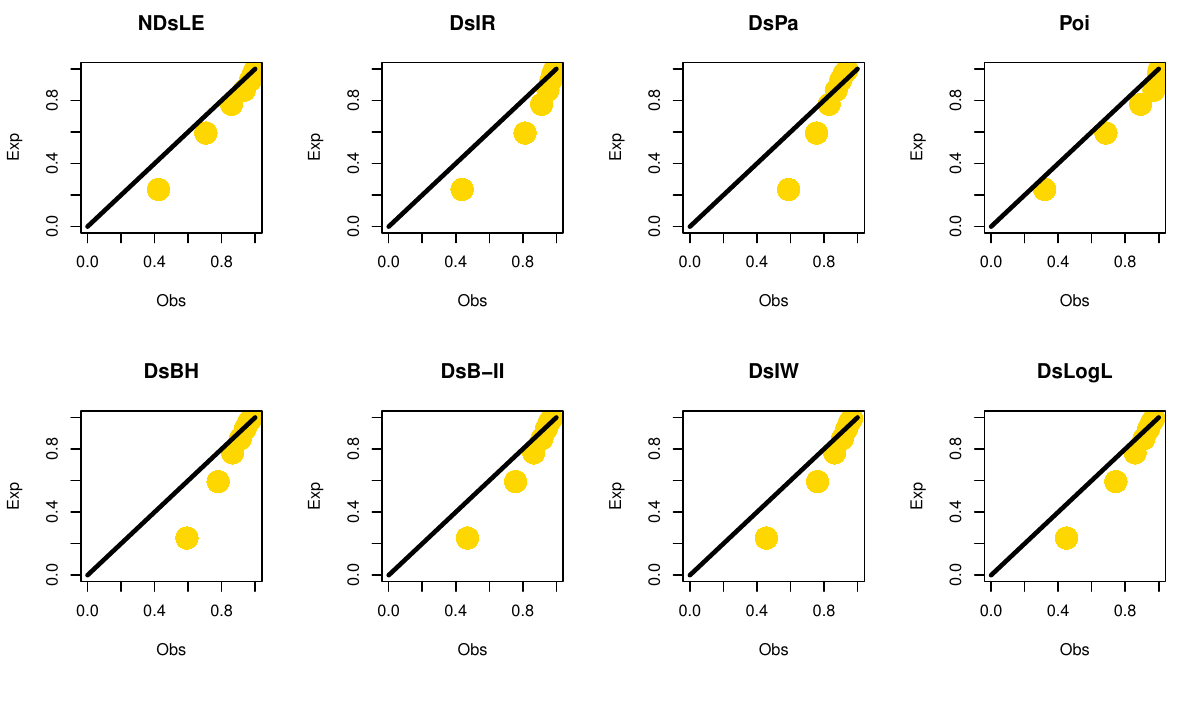
Figure 8. The empirical PPs plots for data set I.